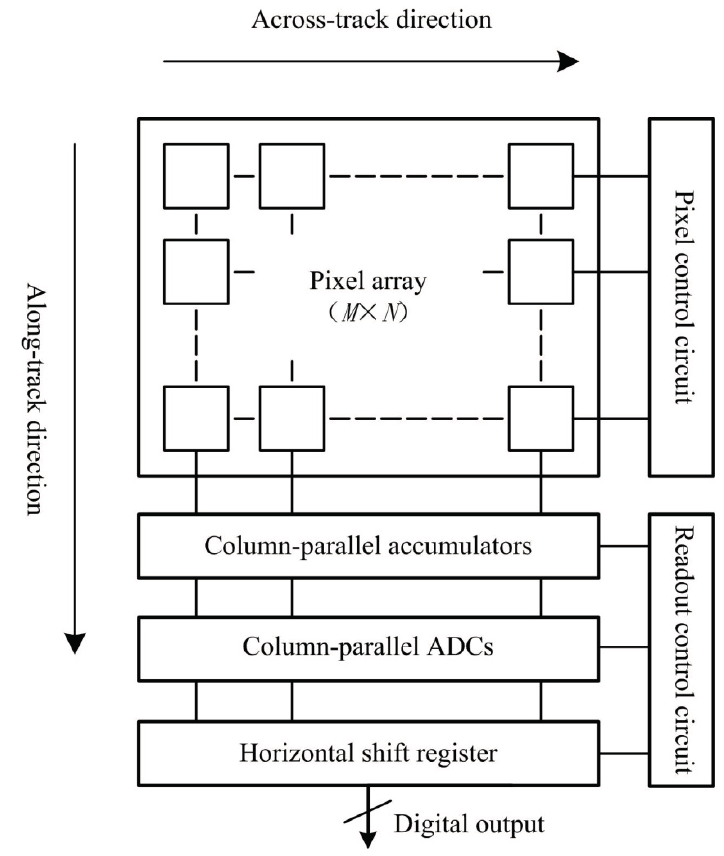
Figure 1. Block diagram of